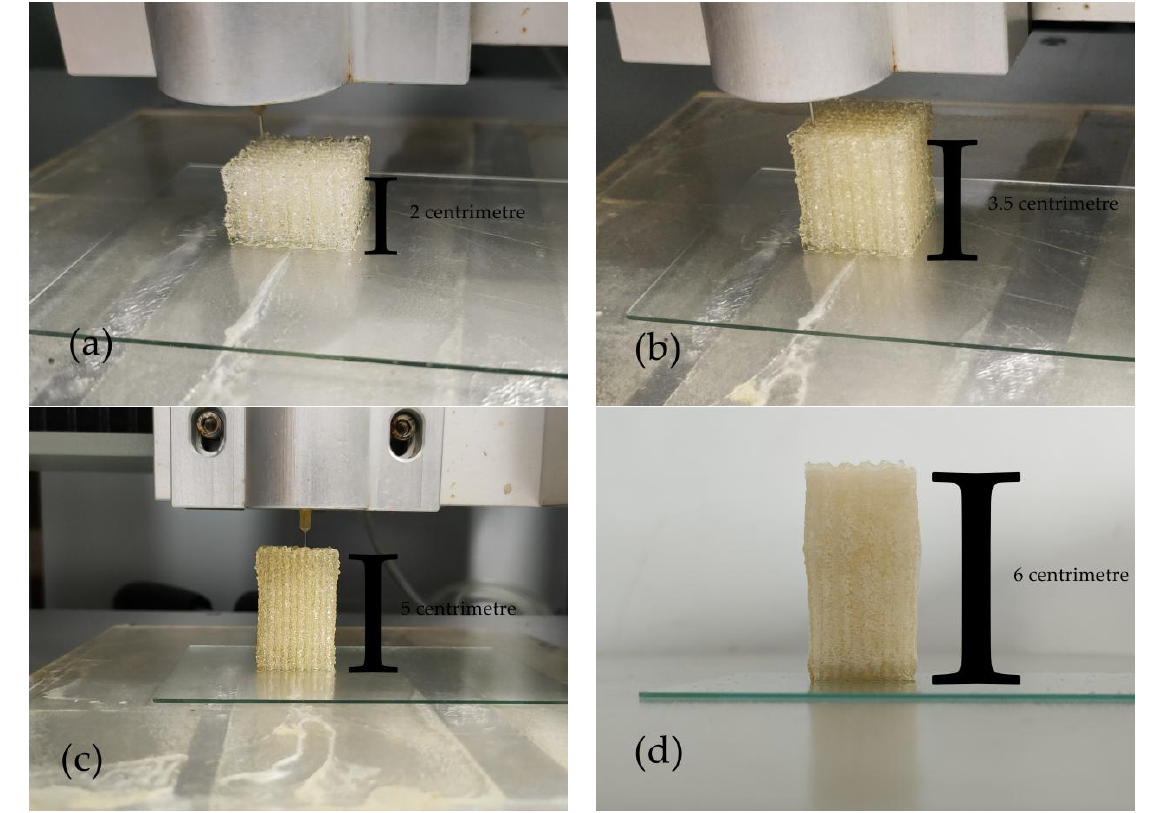
Figure 6. The 3D printed structures of gelatin/alginate/agarose hydrogel at 24 °C. ( a ) A fifty-layer structure. ( b ) An eighty-layer structure. ( c ) A one-hundred-and-ten-layer structure. ( d ) A one-hundred-and-thirty-six-layer structure.